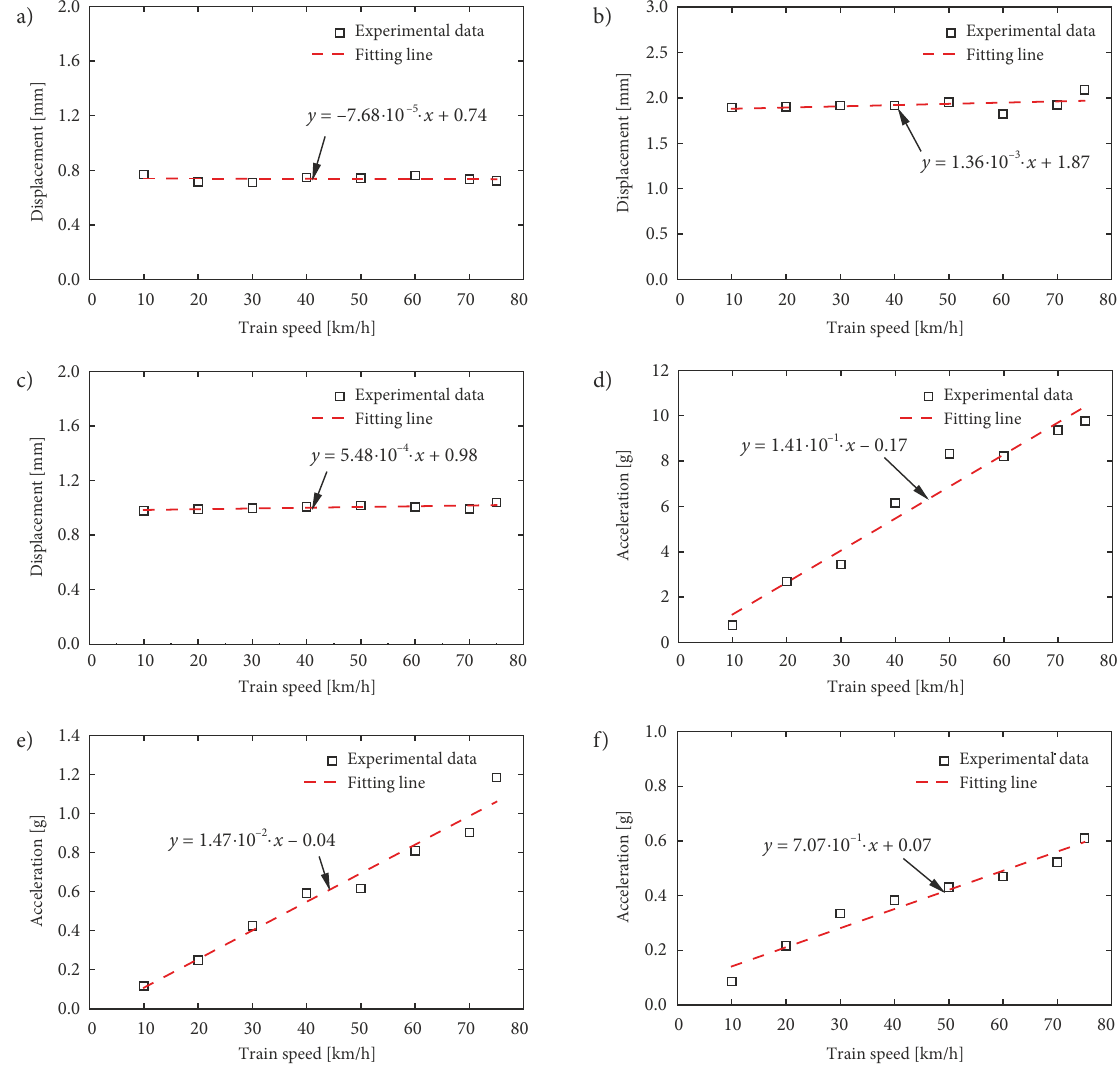
Figure 11. Statistical results as increase of train running speed: a – rail lateral displacement; b – rail vertical displacement; c – sleeper vertical displacement; d – rail vertical acceleration; e – sleeper vertical acceleration; f – ballast bed vertical acceleration vary with train speed increasing